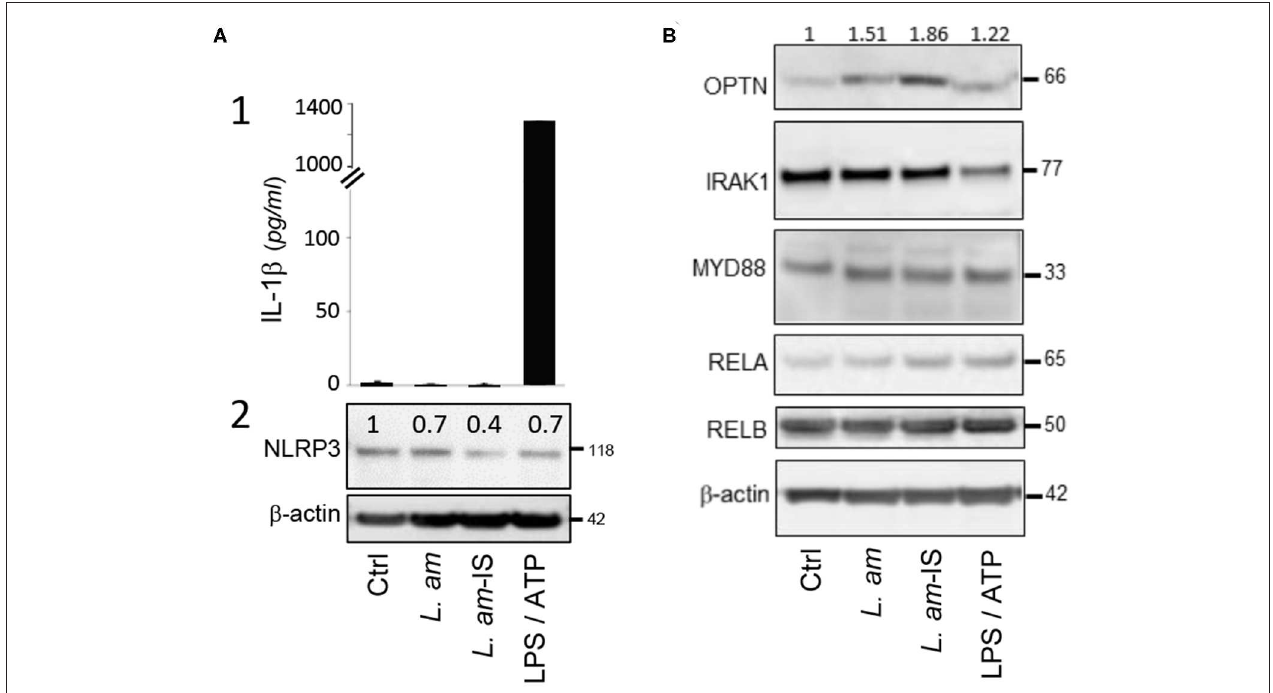
FIGURE 2 | Analysis of protein abundance of key components of the TLR – NF-kB – NLRP3 axis. BMDCs alone (Ctrl), treated with LPS/ATP for inflammasome activation, or incubated for 24h with either BCG or L. amazonensis amastigotes without ( L. am ) or with Ab-opsonized ( L. am -IS) were analyzed. (A) Analysis of DC inflammasome priming and activation. The status of inflammasome priming and activation was analyzed following IL-1 β secretion into culture supernatants and quantifying NLRP3 expression in cell lysates. (1) IL-1 β was quantified by ELISA and data displayed as the mean quantity of IL-1 β ± SEM (technical duplicates of one representative experiment, n = 2 independent experiments). (2) NLRP3 detection by Western Blotting. Values shown on top of the lanes indicate the relative abundance of the normalized value of NLRP3 to β -actin compared to control DCs (Ctrl). (B) Protein expression of key members of the TLR-NF- κ B signaling pathway. The abundance of OPTN, IRAK1, MYD88, RELA, and RELB in cell lysates was analyzed by Western Blotting. Values shown on top of the lanes indicate the relative abundance of the normalized value of OPTN protein to β -actin compared to control DCs (Ctrl) for a representative Western Blot ( n = 2 independent